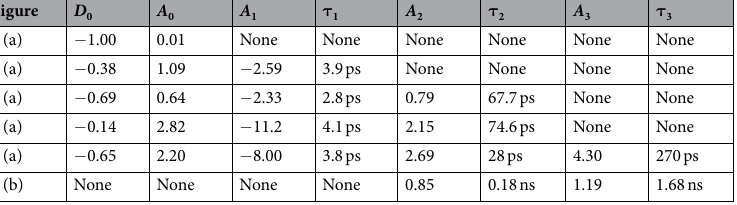
Table 1. The fitting parameters of the response functions in Eq. (1) of each figure. Note that the amplitudes such as D 0 , A 0 , and A 1 are not comparable between figures. But the scale of amplitudes in each figure keep comparable. The parameters of Fig. 4(b) were obtained without convolution